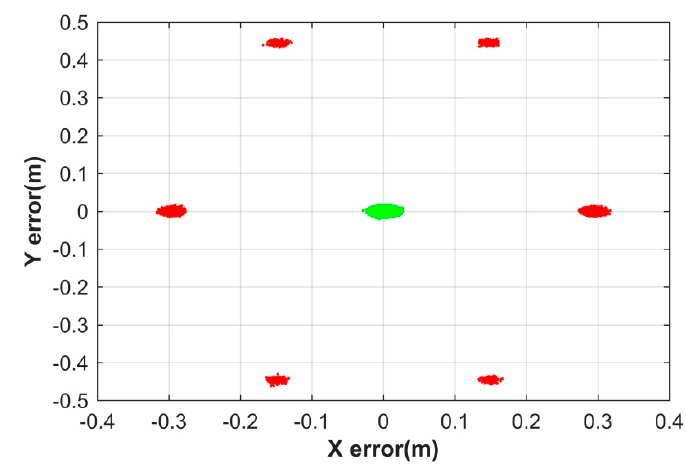
Figure 8. Scatterplot of positioning errors for the correct fix solution (green dots) and wrong fix solution (red dots).